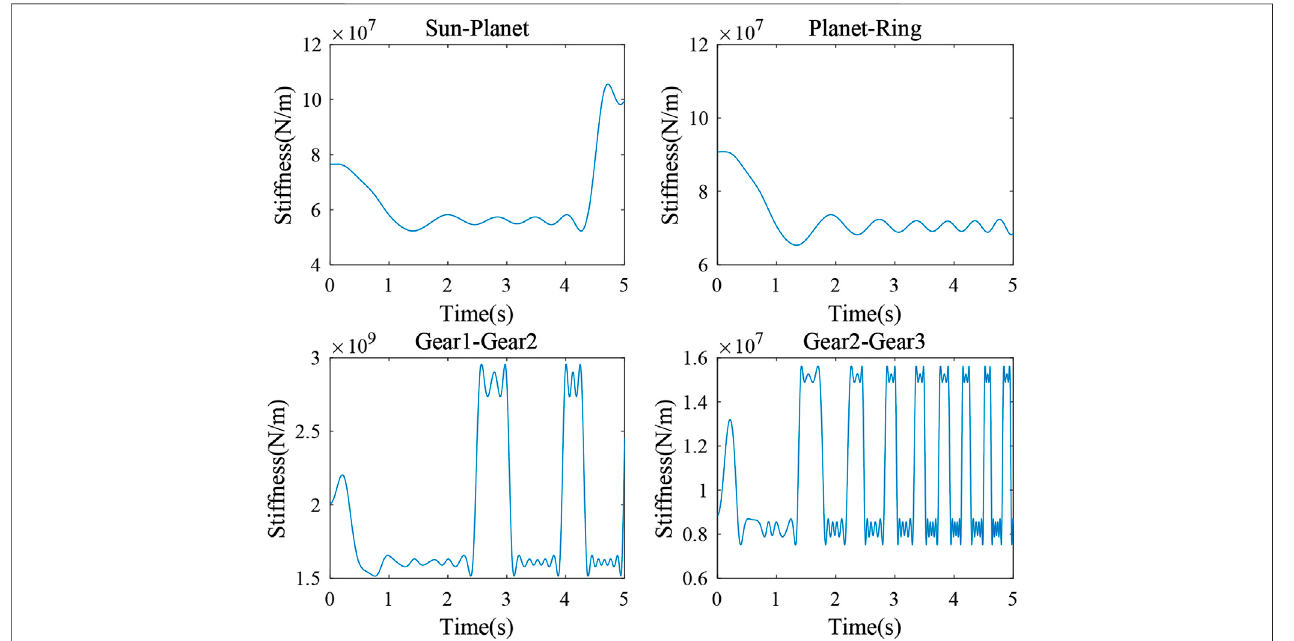
FIGURE 3 | Varying gear mesh stiffness model.